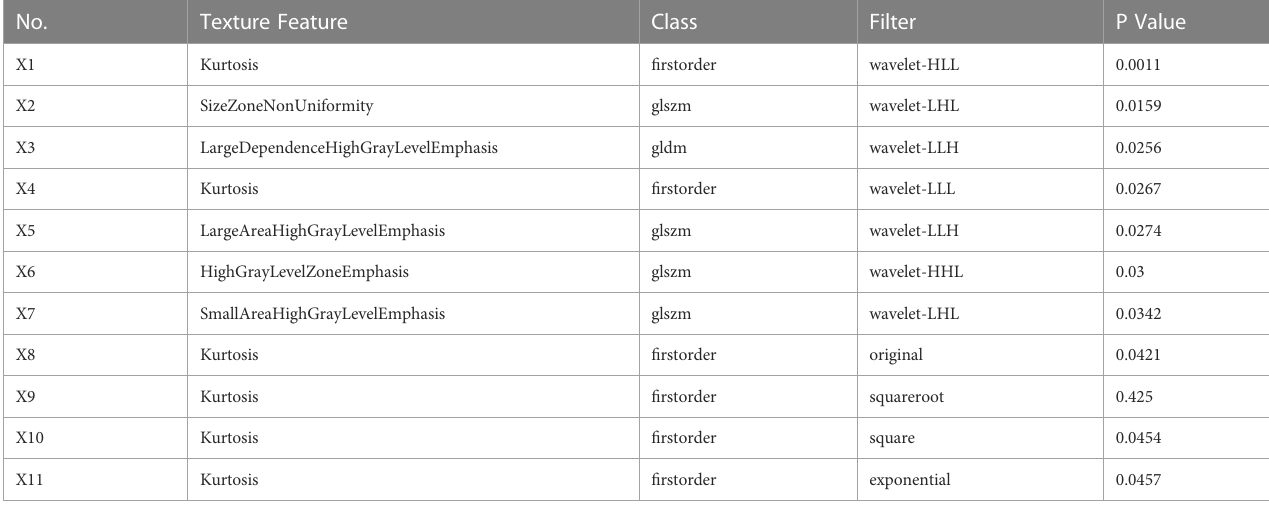
TABLE 3 Optimal texture features from the arterial phase.